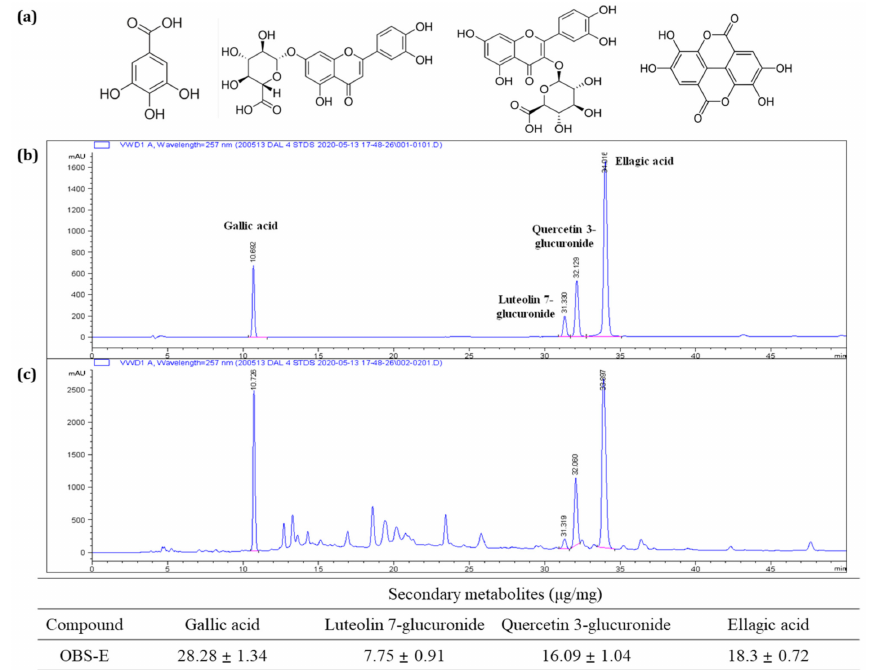
Figure 4. HPLC- ultraviolet detector (UVD) chromatogram of standard references and OBS-E and contents of major ingredients in OBS-E. ( a ) HPLC chromatogram of a mixture of standard references (250 µ g/mL, each), ( b ) HPLC chromatogram of OBS-E (10 mg/mL), ( c ) chemical structure of gallic acid, luteolin 7-glucuronide, quercetin 3-glucuronide, and ellagic acid, respectively. Standard materials and OBS-E were applied to the HPLC system and detection was performed at 257